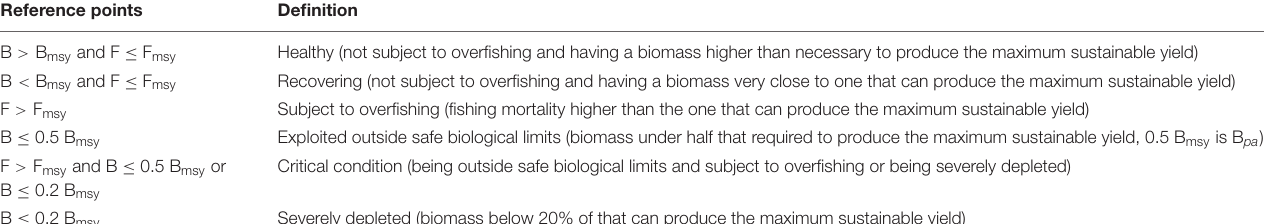
TABLE 2 | Definition of stock status according to fisheries reference